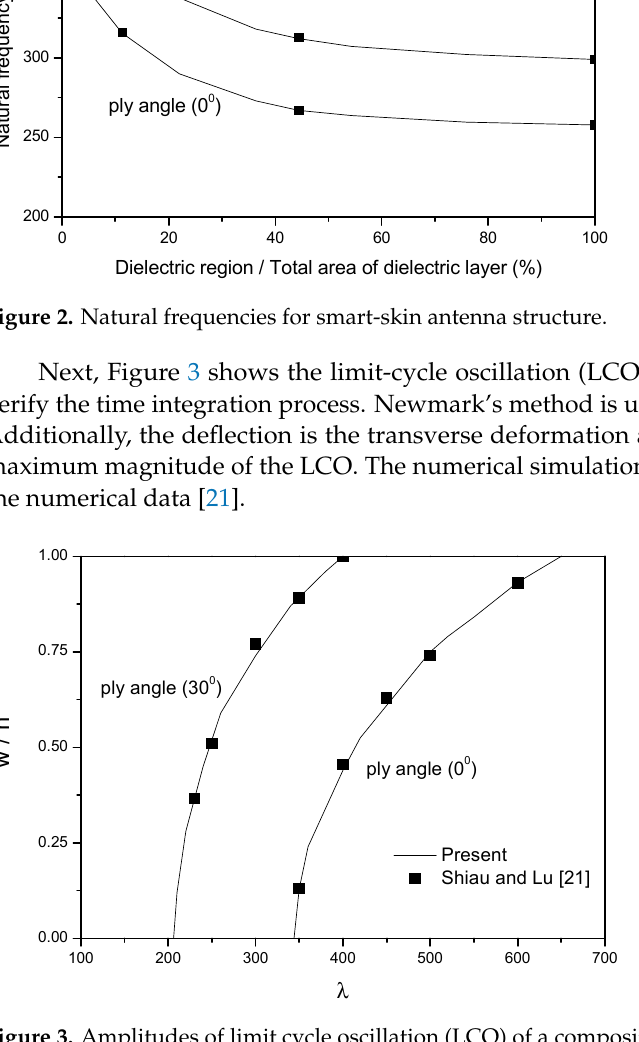
Figure 3. Amplitudes of limit cycle oscillation (LCO) of a composite model. Finally, Figure 4 depicts the deflection behaviors of a cantilevered plate. The linear static analysis of the model with the upper layer and lower surface with piezoelectric materials placed on them. The input voltage is chosen as 10 V , and the stacking sequence of the model is [ − 45/45/ − 45/45]. The material properties for graphite/epoxy and PZT used in this case are presented in Table 2. The numerical result also shows good agreement with the data in Ref.